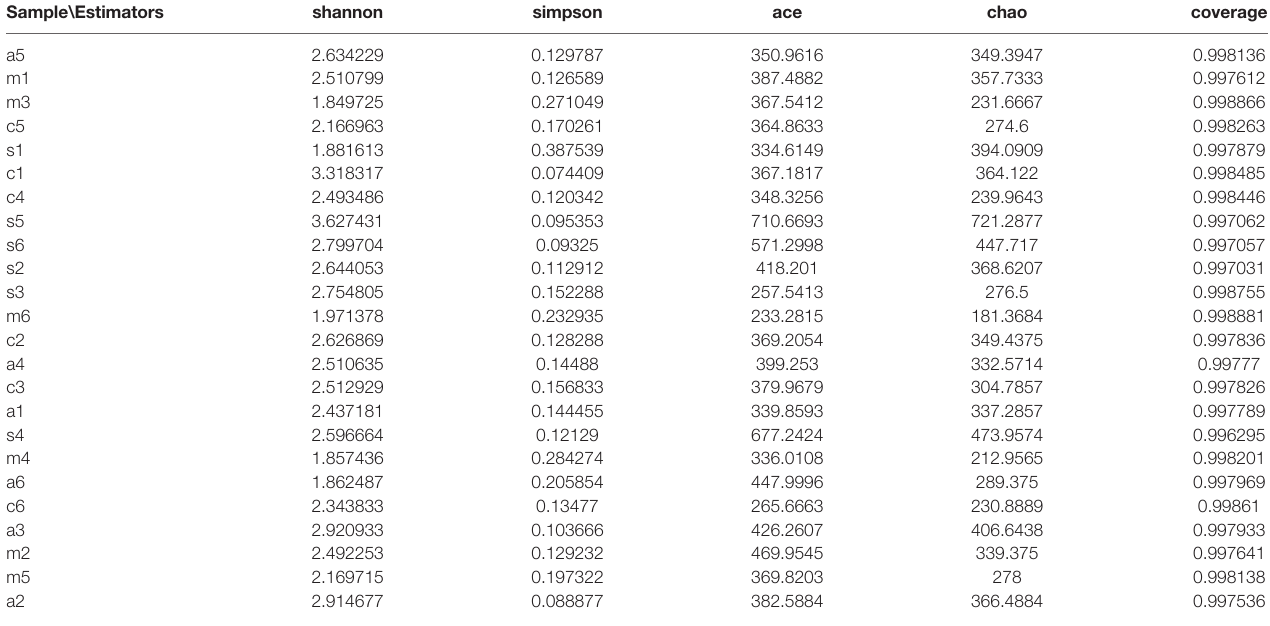
TABLE 1 | Diversity forms. Sample\Estimators